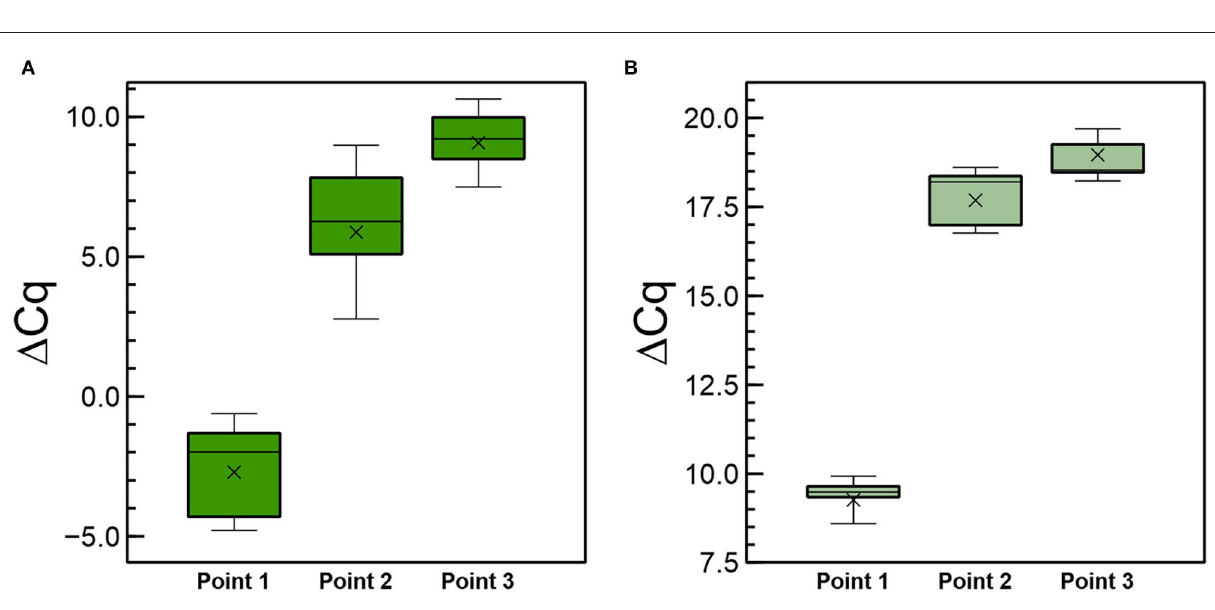
FIGURE 7 | Quantitative differences of the CP-(ds)RNA (A) and the 6,125-vsiRNA (B) detected by RT-qPCR at 3 dpt after spraying the CP-dsRNA in local (point 1), close distal (point 2), and far distal (point 3) sampling as described in Figure 8